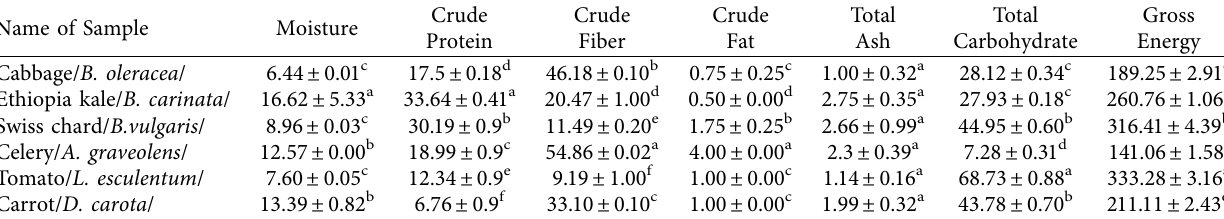
Table 1: Proximate compositions (dwb) of composite vegetable